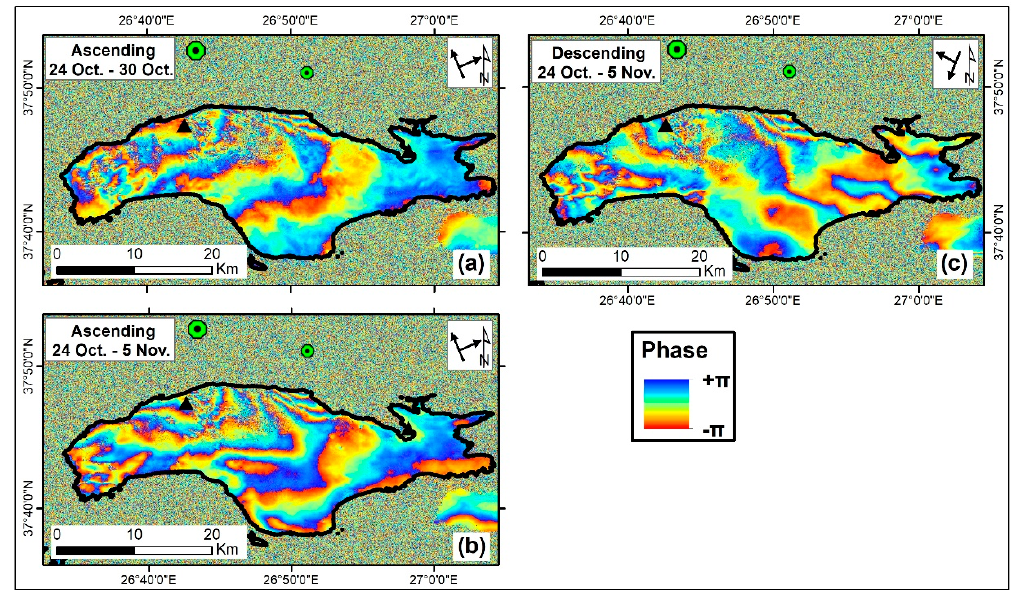
Figure 6. Wrapped phase InSAR maps derived from the Sentinel 1 satellites on ( a , b ) ascending and ( c ) descending orbital trajectory. Color scale ( − π to π ) describes one cycle of phase difference between the reference and repeat SAR images in the line-of-sight direction (LOS), which represents 28 mm of ground displacement along this direction. Black triangles mark the two GNSS stations on Samos (SAMO to the west and SAMU to the east). Green polygons mark the earthquake and the strongest aftershock. Inset arrows indicate the heading azimuth and look direction of the radar